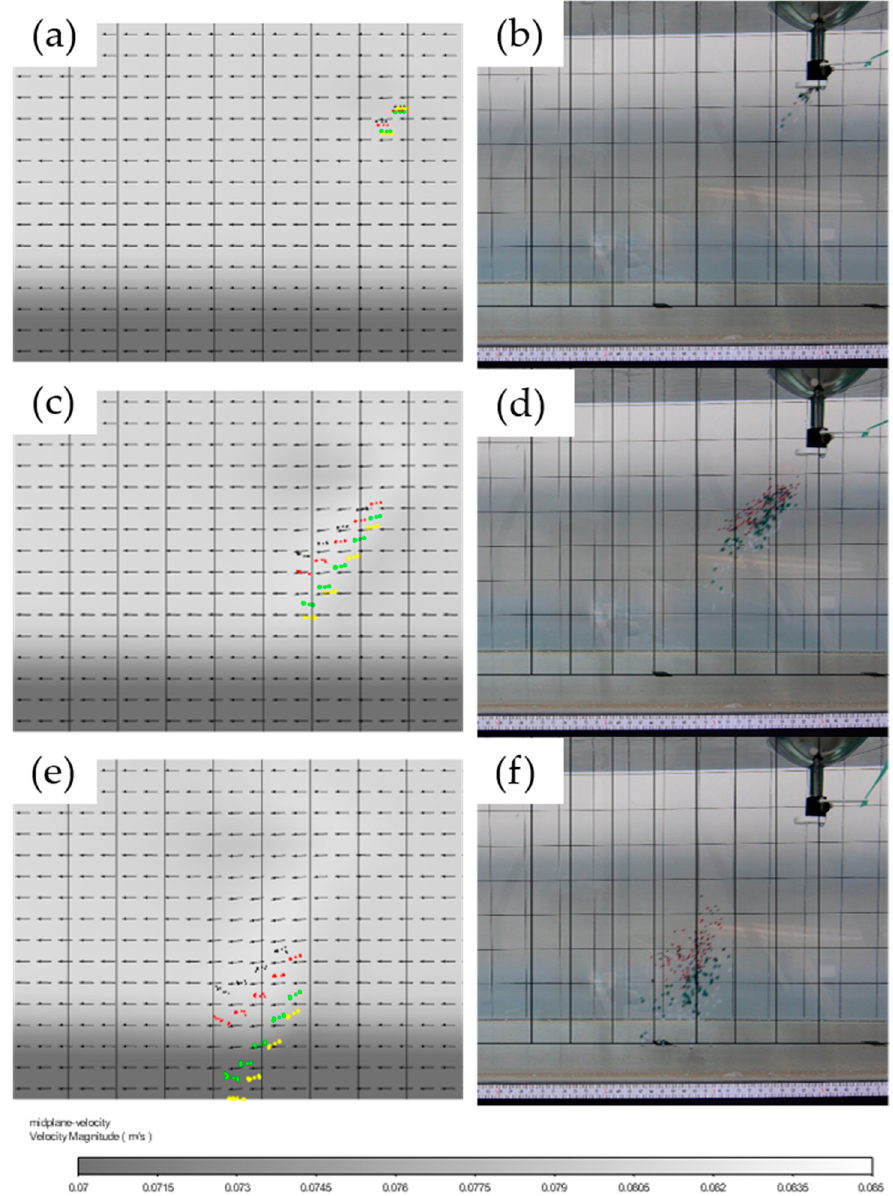
Figure 11. Comparison of the particle cloud as observed in the experiment and the simulation using the DPM approach: ( a ) and ( b ) 0.5 s after the release of particles; ( c ) and ( d ) 1.5 s after the release of particles; ( e ) and ( f ) 2.5 s after the release of particles. Particles are colored by size as described in Table 1. Yellow color is used instead of white in the visualization of the simulation results.